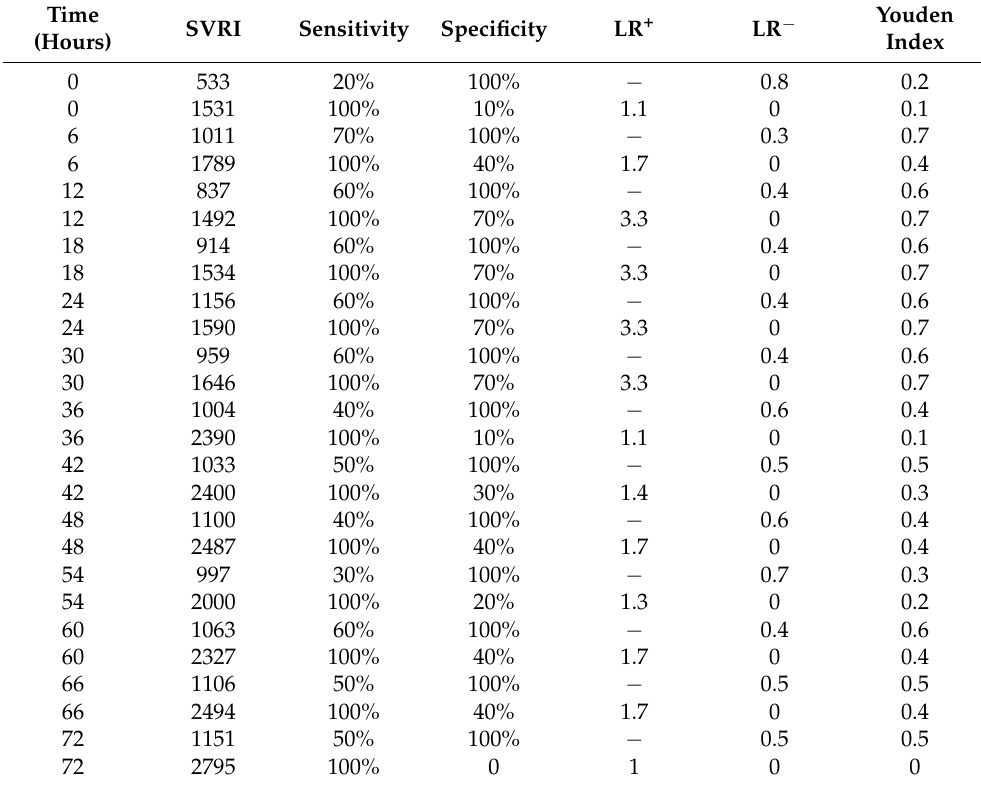
Table 5. Two cutoff values for SVRI in predicting clinical outcomes with 100% specificity and 100% sensitivity at 6 h